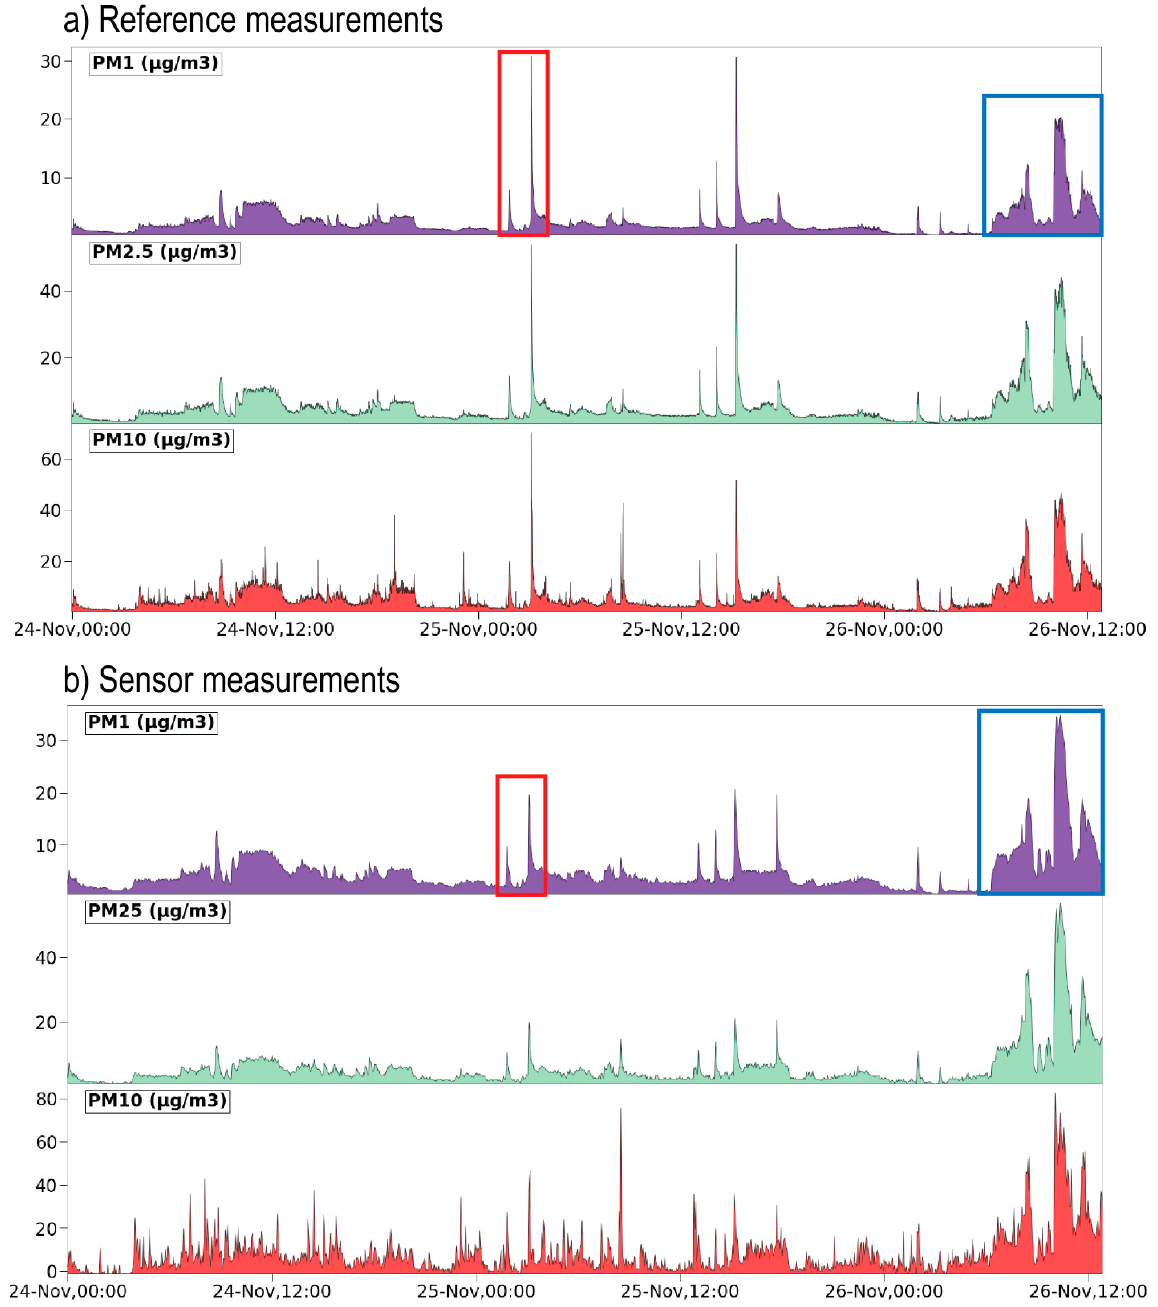
Figure 5. Measured concentration of particulate matter in the wheelhouse of the old ship over time as determined with a high-end and low-cost optical particle counter monitoring. The measuring campaign covered the period 24–26 November 2020; ( a ) Reference measurements performed with the Grimm; ( b ) Measurements performed in the same room with the sensor box containing the Alphasense OPC-N3 sensor. The peak ratio in the red rectangle as determined by the 2 instruments are different. For the blue rectangle, the peak height of the largest peak as measured by the sensor is higher than for the reference measurement.